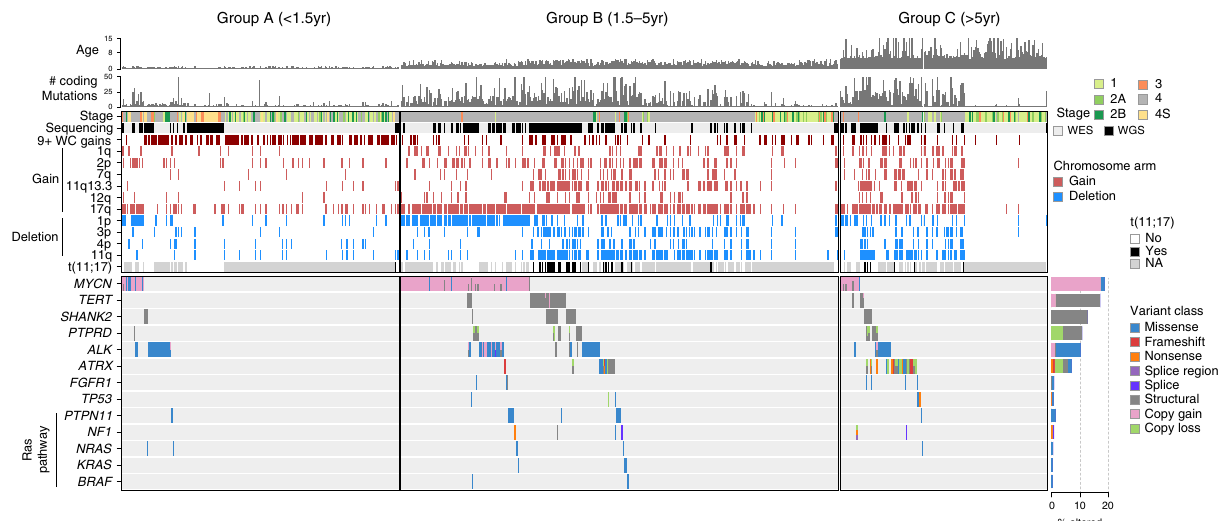
Fig. 1 Recurrent somatic alterations by age group in neuroblastoma. Top, age at diagnosis and number of coding mutations in each of 685 neuroblastoma samples (662 diagnosis, 23 relapse) sequenced by WGS or WES, with samples categorized into <18 months of age at diagnosis (group A, n = 206), 18 months to 5 years (group B, n = 325), and 5 or more years (group C, n = 154). Middle, segmental chromosome copy changes which were statistically signi fi cant per GISTIC analysis, and structural variants; blue indicates segmental copy loss, red indicates segmental copy gain, white indicates no change. 9 + WC gains samples (gain of nine or more whole chromosomes) are shown in dark red. Bottom, somatic variants in driver genes. Color indicates the type of mutation (key at right). Samples with more than one mutation type for a gene have multiple colors indicated. Signi fi cantly mutated genes (SMGs), as identi fi ed through MutSigCV and/or GRIN, range from MYCN at the top to ATRX at the bottom, while the remainder are known cancer genes that have pathogenic variants in our cohort but did not pass the SMG test. Barplot to the right shows percentage of samples with each gene somatically altered, and variant type indicated by color; the denominator was 685 samples for all alterations except for t(11;17), TERT , SHANK2 , and PTPRD (205 samples with WGS as these variants required WGS to detect) and ATRX (522 samples including WGS samples plus WES samples with ATRX targeted sequencing allowing SV detection). Copy gains include focal MYCN ampli fi cations with log 2 fold change of >2.0 (>8 copies); ALK copy gains meeting this criterion or one-copy ALK gains associated with a likely activating SV; or focal TERT gains of one copy or